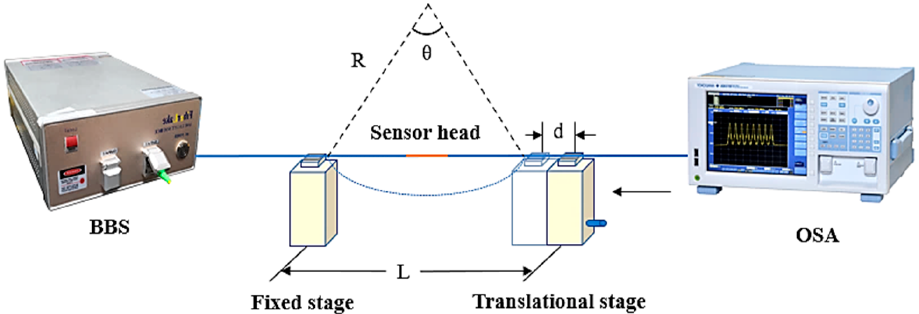
Figure 6. Diagram of experimental setup.